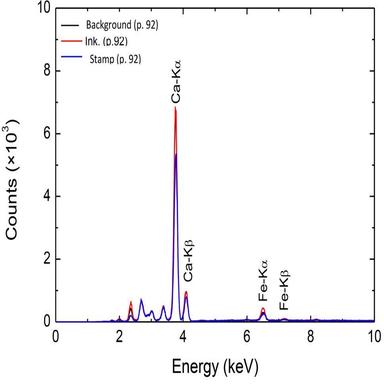
Comparison of fluorescence spectra of the paper background (in black), of the written part (in red) and of the stamp (in blue) of the manuscript 157 page 92.